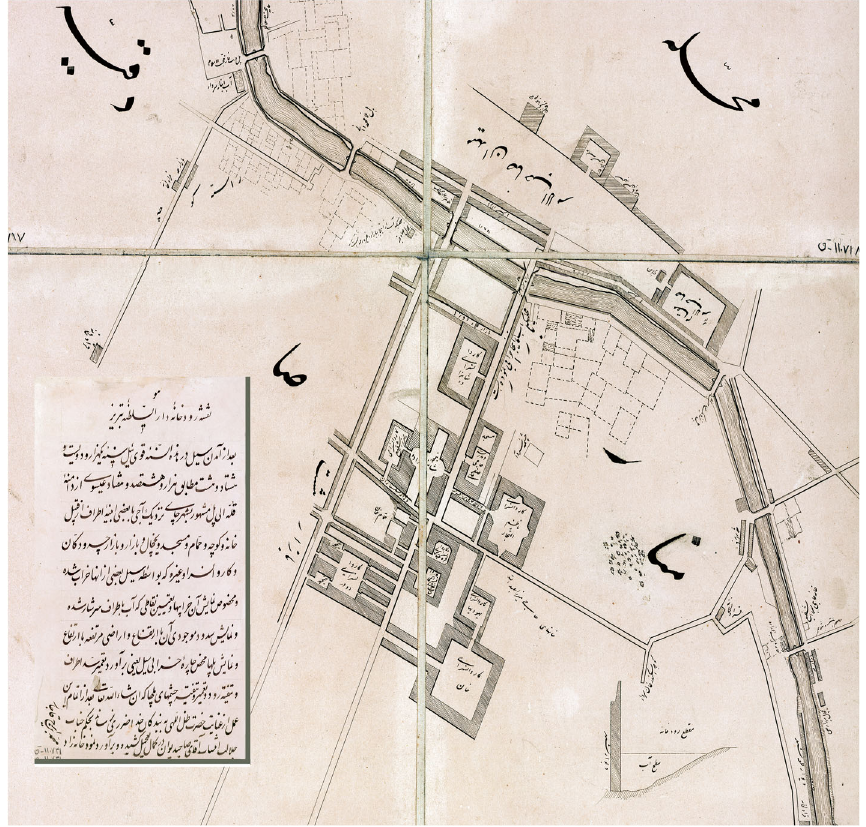
Fig. 6 The map prepared for town renewal in Tabriz after the 1870 flood (Source: ICHHTO 2009,